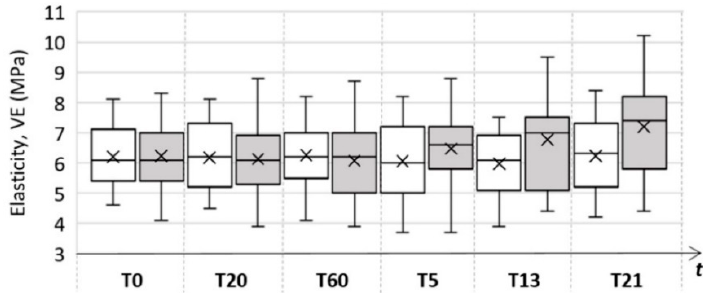
Figure 3. Elasticity measurements of the control and test area in the short-term and long-term study (grey boxes are test values, white are control).